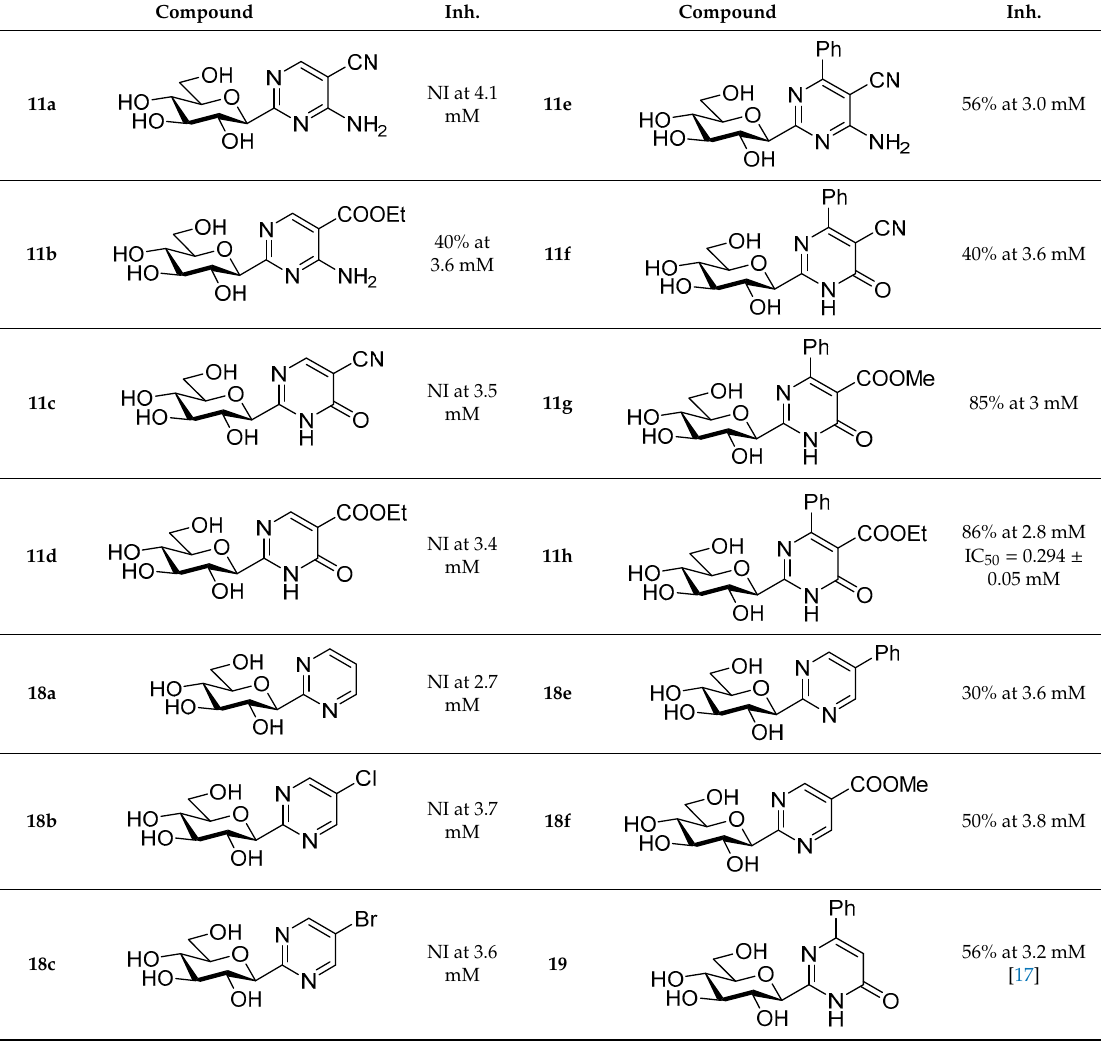
Table 3. Inhibition of bovine liver β -galactosidase by the new 2- C -( β -D-glucopyranosyl)-pyrimidines. Compound Inh. Compound Inh. NI at 4.1 56% at 3.0 11a